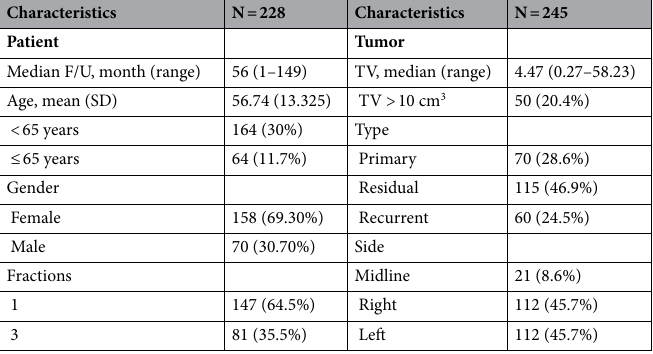
Table 1. Patient and tumor characteristics. F/U follow-up, SD standard deviation, TV tumor